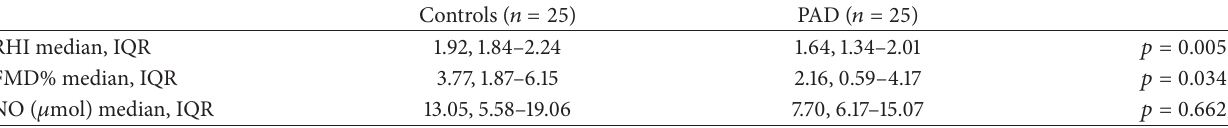
Table 2: RHI, FMD, and NO results for age and gender matched controls and patients with PAD.